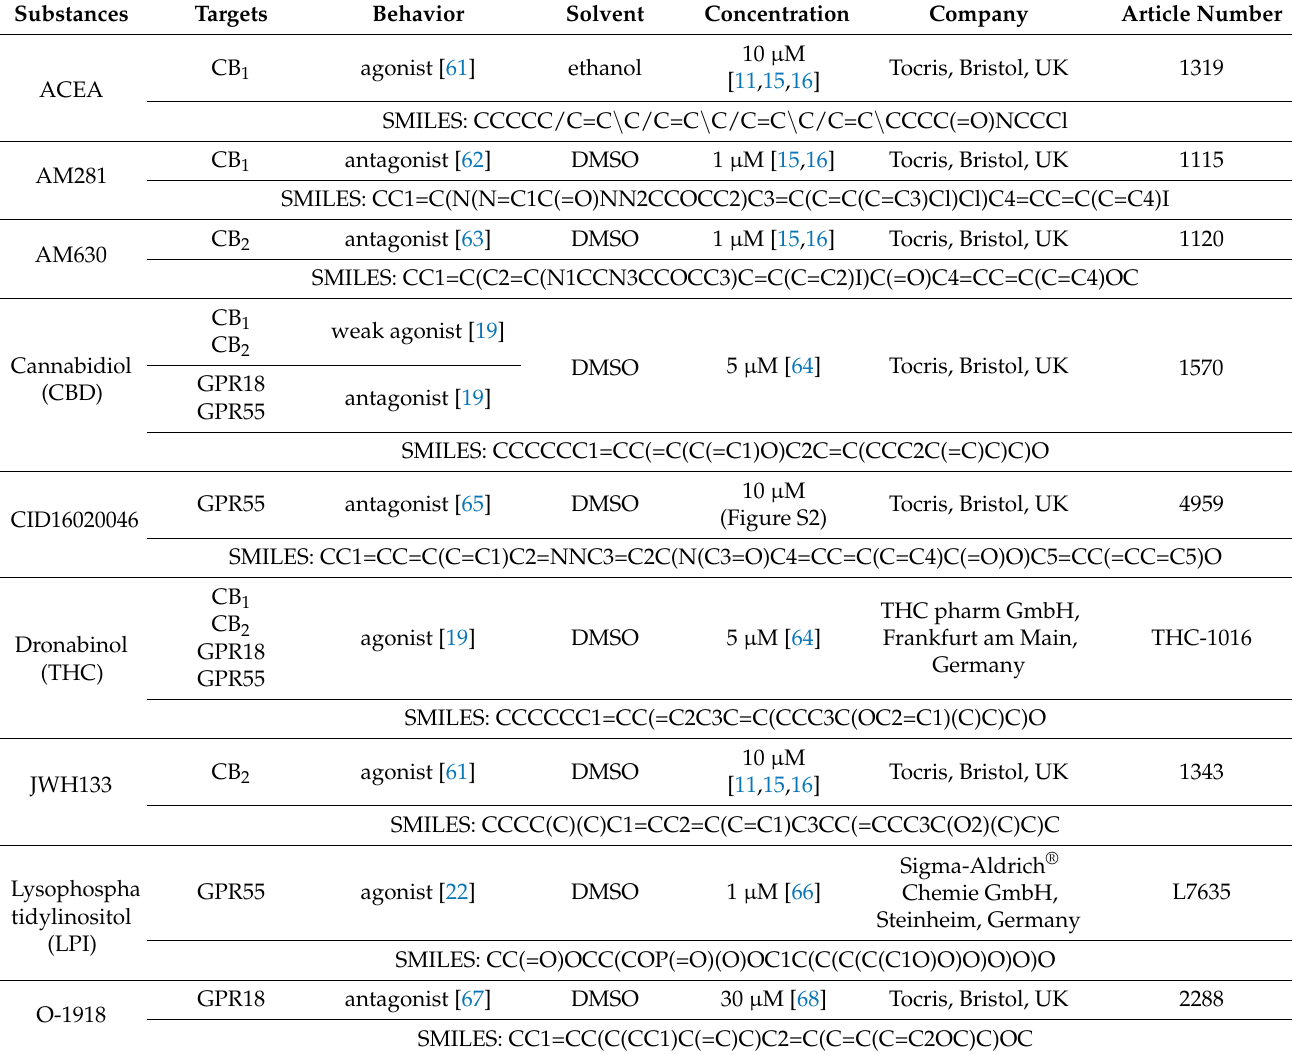
Table 1. Cannabinoids and